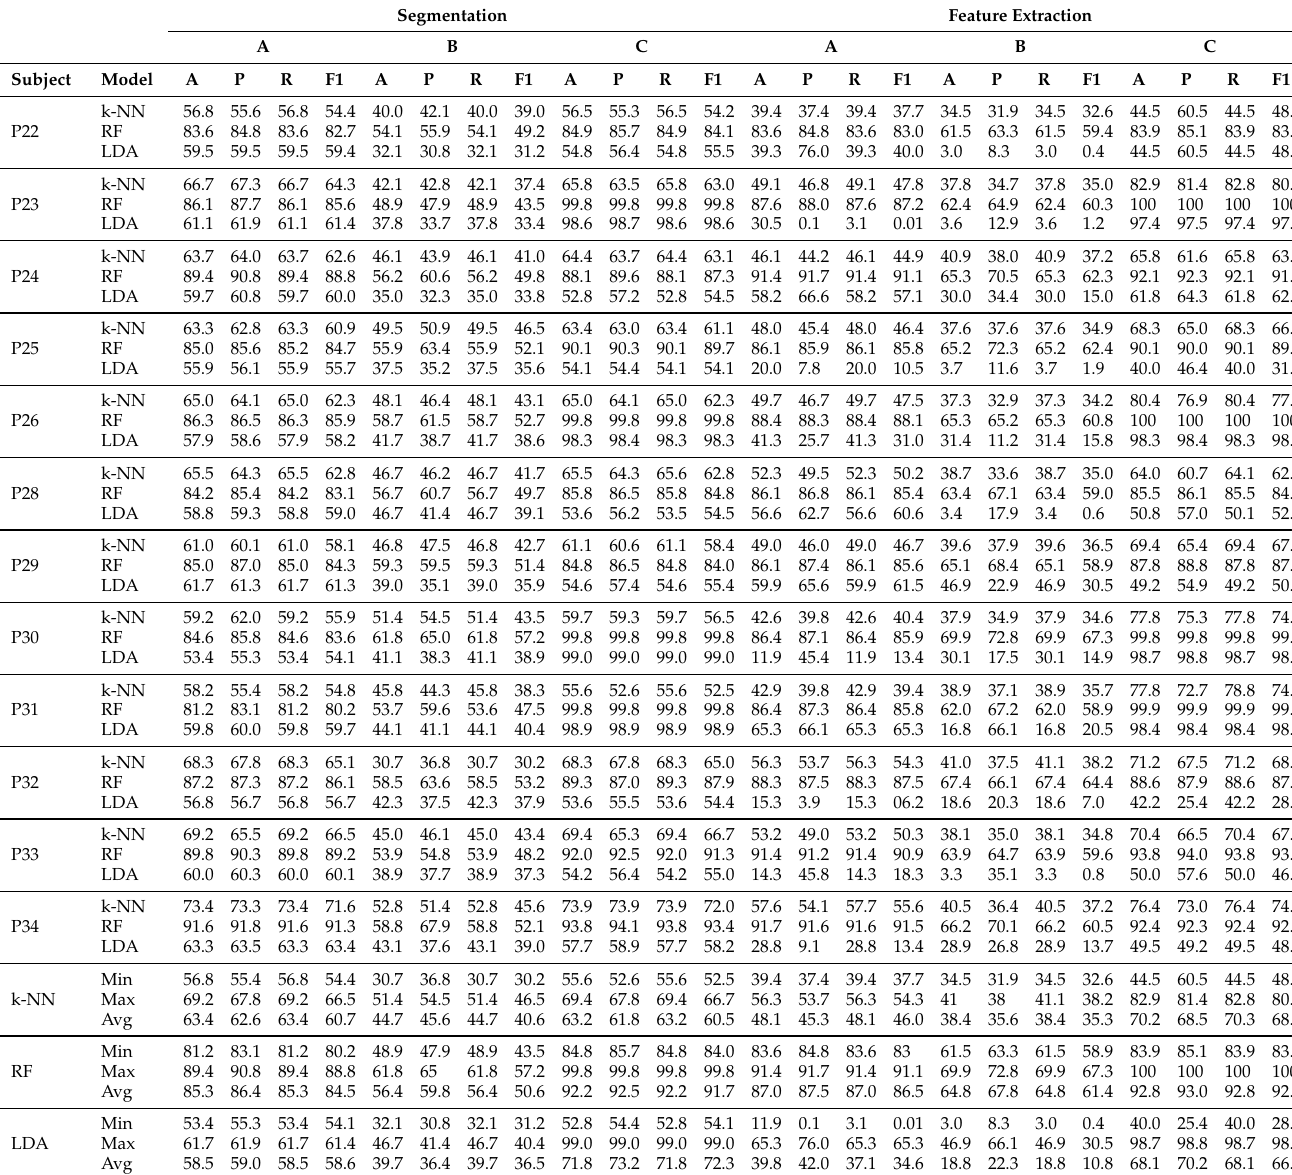
Table 5. Results on segmentation and feature extraction data representation for each